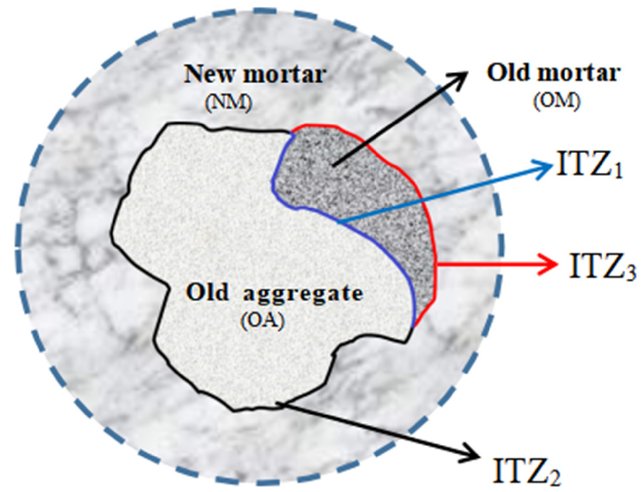
Figure 1. Diagram of multiple interface areas.